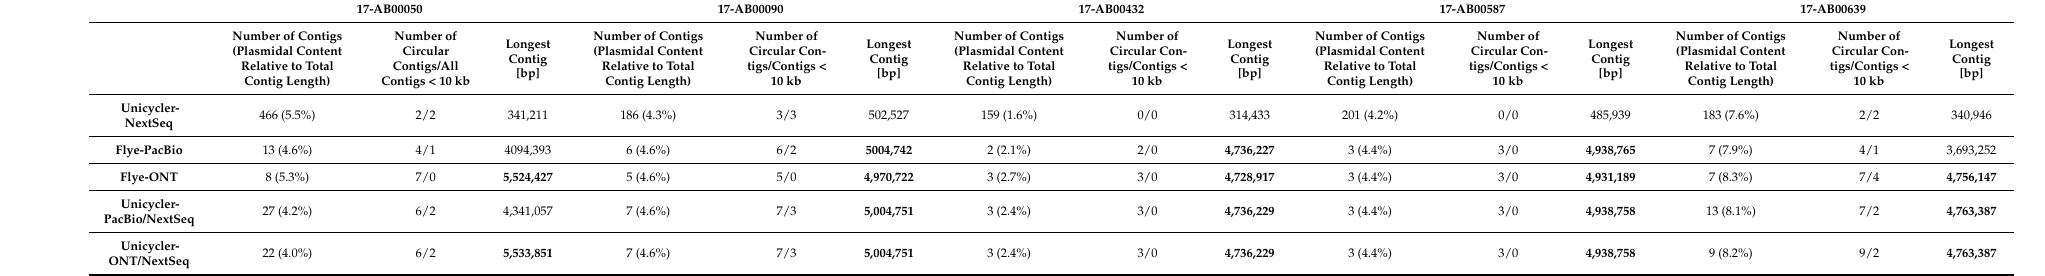
Table 2. Characteristics of contigs detected with different sequencing and assembly strategies in five E. coli isolates. Circularized contigs are presented in